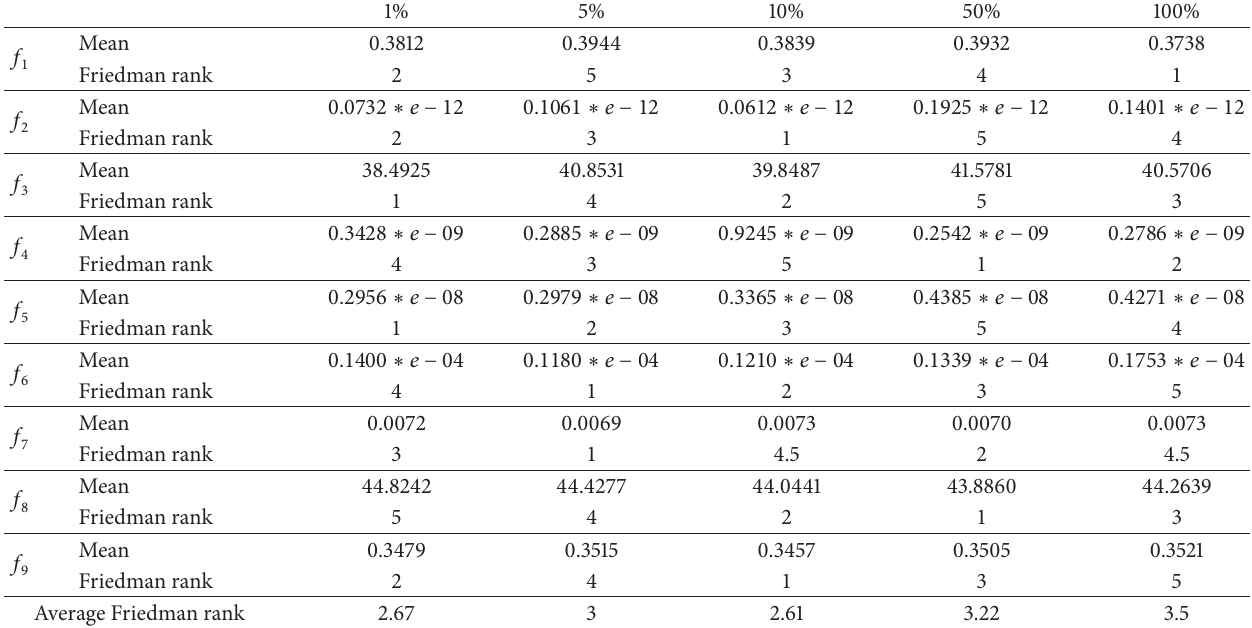
Table 14: Friedman test on the effect of Δ